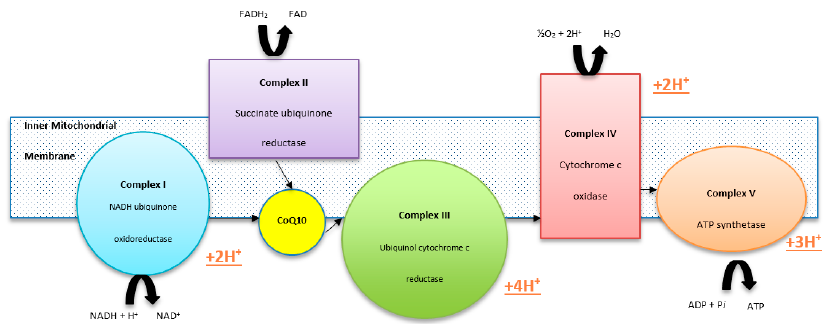
Figure 2. The mitochondrial electron transport chain.